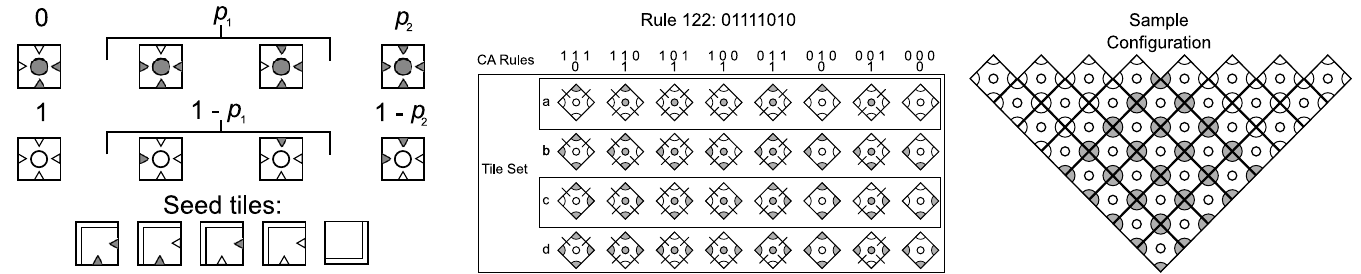
Fig 7. Seed tiles and transition probabilities of probabilistic cellular automaton DKCA assemblers (Left). The tile set (Center) for ECA rule 122 uses tile concentrations and nondeterminism to weakly assemble a variety of patterns (without spontaneous generation) from random seeds, as illustrated on the Right.